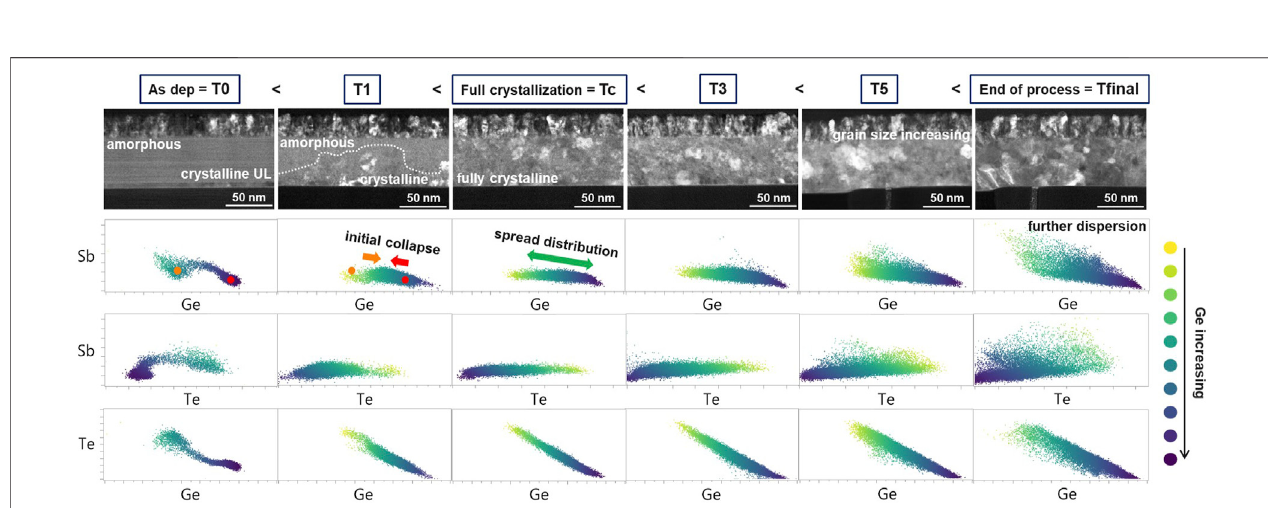
FIGURE 2 | Morpho-chemical results of 6 signi fi cant BEOL steps along the entire process evolution: in the fi rst line, DF-STEM images of patterned PCM stack are reported,where crystalline andamorphous contrastsarehighlighted; inthesubsequentlines,elementalscatterplotsofSbvs. Ge,Sbvs.Te,andTevs.Gearereported with the main focus on Sb vs. Ge